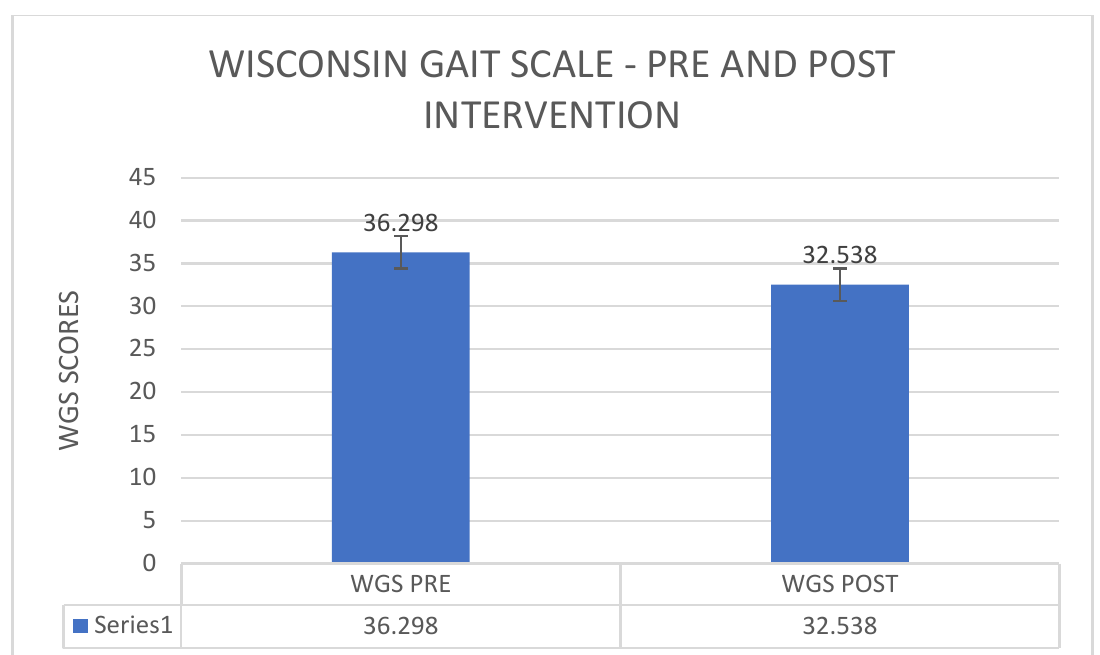
Figure 3. Pre–post comparison of trunk impairment scale.